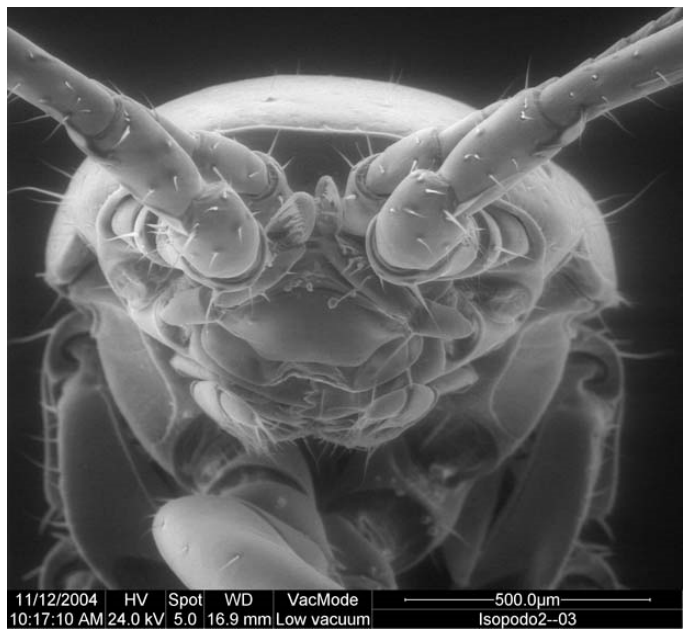
Figure 1. Isopod Stenasellus virei buchneri . Photo ESEM, MNCN, Madrid.